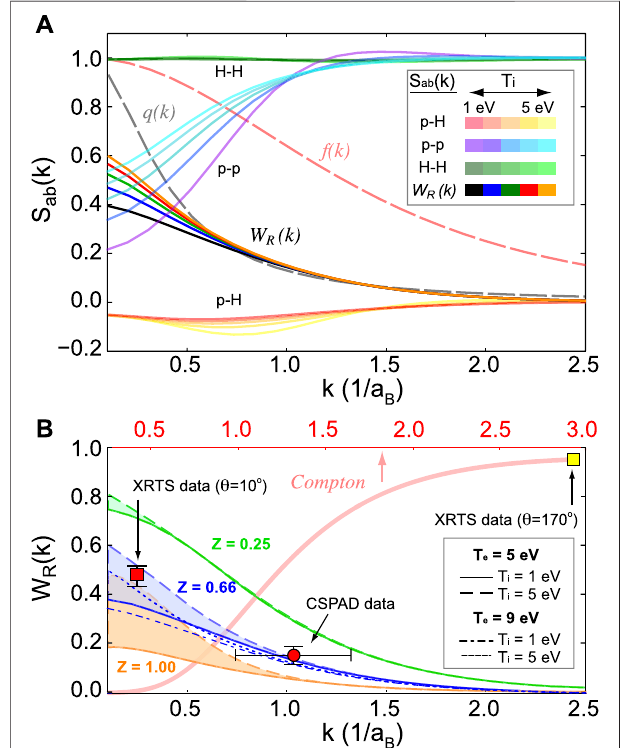
FIGURE4| (coloronline) (A) Non-equilibriumHNCstaticstructurefactor for hydrogen as a function of ion temperature, at a fi xed electron temperature of T e = 5 eV, showing all contributing correlations (S ab ( k )) in a partially ionized plasma of Z = 0.66. The hydrogen-hydrogen (black line), proton-proton (blue line), and hydrogen-proton (red line) distributions/structure as well as contributions from the screening cloud q(k) (dashed grey), atomic form factor f(k) (dashed red). (B) Quasi-elastic X-ray Thomson scattering data measured for high-q and low-q spectrometers compared to theoretical static structure factors using Z f = 1.0, Z f = 0.66, and Z f = 0.25 measured at t = 2.5 ps? Each ionization includes the angular intensity distribution for T i = 1 eV and T i = 5 eV for an electron temperature of T e = 5 eV and T e = 9 eV plotted for Z f = 0.66. The red square data point is a measurement of the background corrected elastic signal strength W R (k = 52 nm − 1 ) representing a unique combination of T e and T i conditions, and the yellow data point is the inelastic Compton signal (k = 4.8 nm − 1 ) used to normalize all signal strength measurements. The red circle data point is the average background corrected intensity signals measured with the CSPAD as a way to benchmark the ionization ( Z f